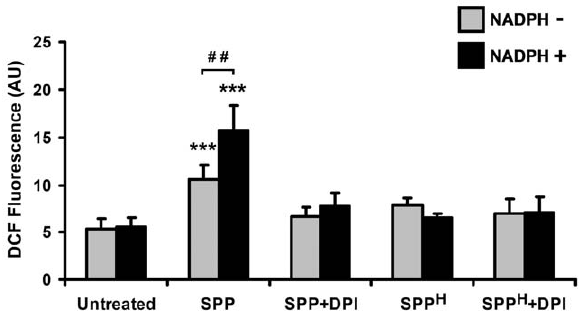
Figure 2. Exposure to SPPs increases the intracellular ROS levels in human moDCs. Cells were incubated with freshly isolated ragweed SPPs for 1 h both in the presence and absence of NADPH. Cells were then loaded with the redox-sensitive H 2 DCF-DA and changes in DCF fluorescence intensities were assessed by flow cytometry. Control experiments were performed using heat-inactivated SPPs and SPPs treated with DPI, an inhibitor of NADPH oxidases. Data are presented as means 6 SEM of three individual experiments. *** p , 0.001 vs untreated DCs, ## p , 0.01. (AU, arbitrary units; DCF: dichlorofluor- escein; DPI: diphenyleneiodonium; SPP: subpollen particle; SPP H : heat- inactivated SPP).